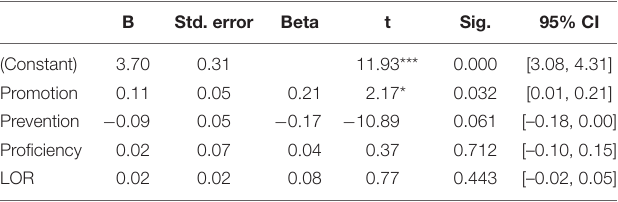
TABLE 5 | Multiple regression results for regulatory focus with DCT score as the outcome